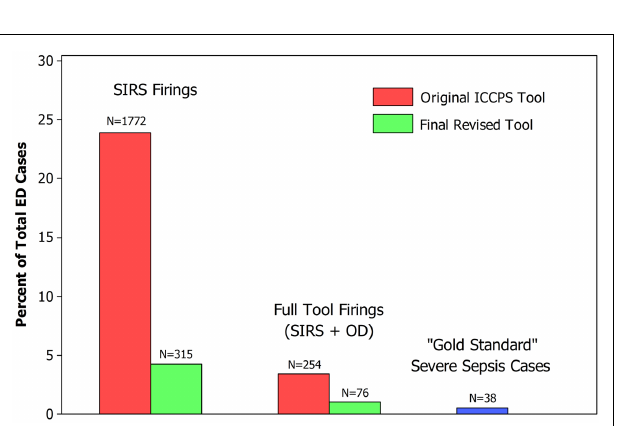
FIGURE 3 | Comparison of ICCPS (2) based tool with final revised tool